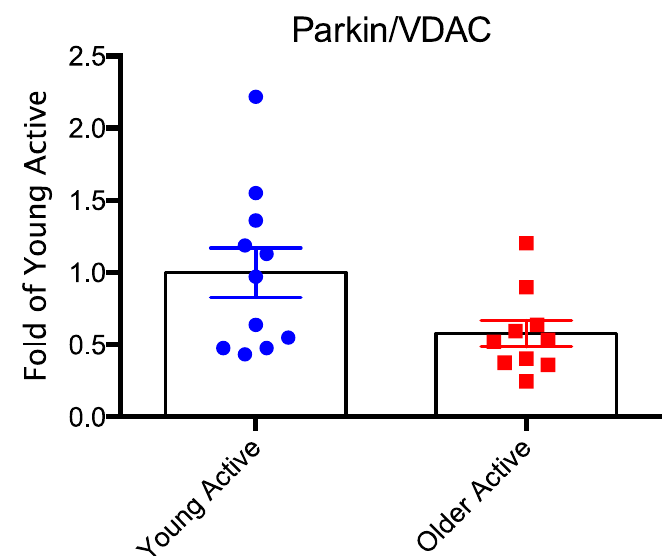
Figure 8. Parkin protein relative to a marker of mitochondrial content (voltage dependent anion channel; VDAC) is reduced in skeletal muscle of older physically active men. Filled blue circles = young physically active; filled red squares = older physically active. Figure adapted from [32].